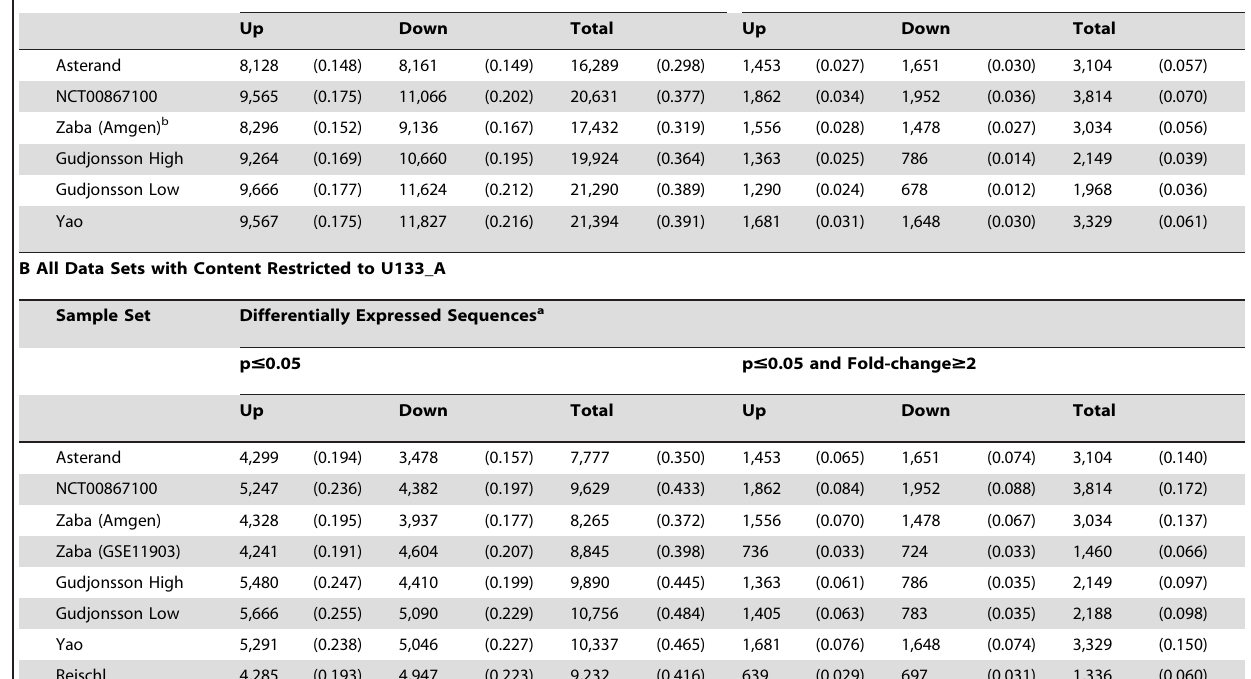
A Data Sets on U133_Plus_2 Sample